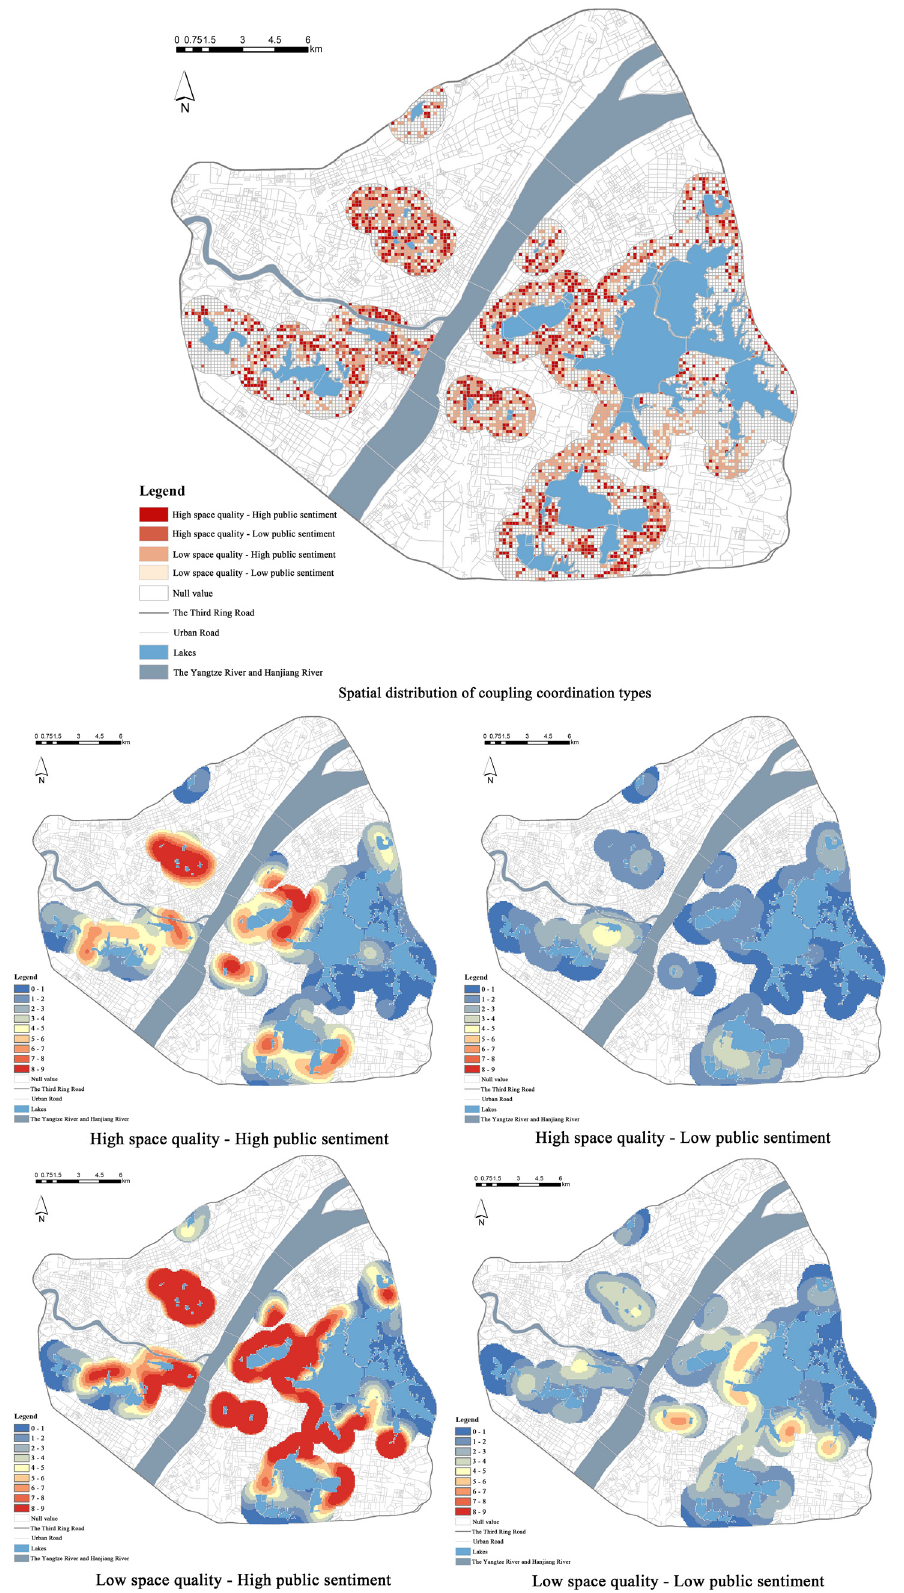
Figure A3. Spatial distribution of coupling coordination type between spatial quality and public sentiment.